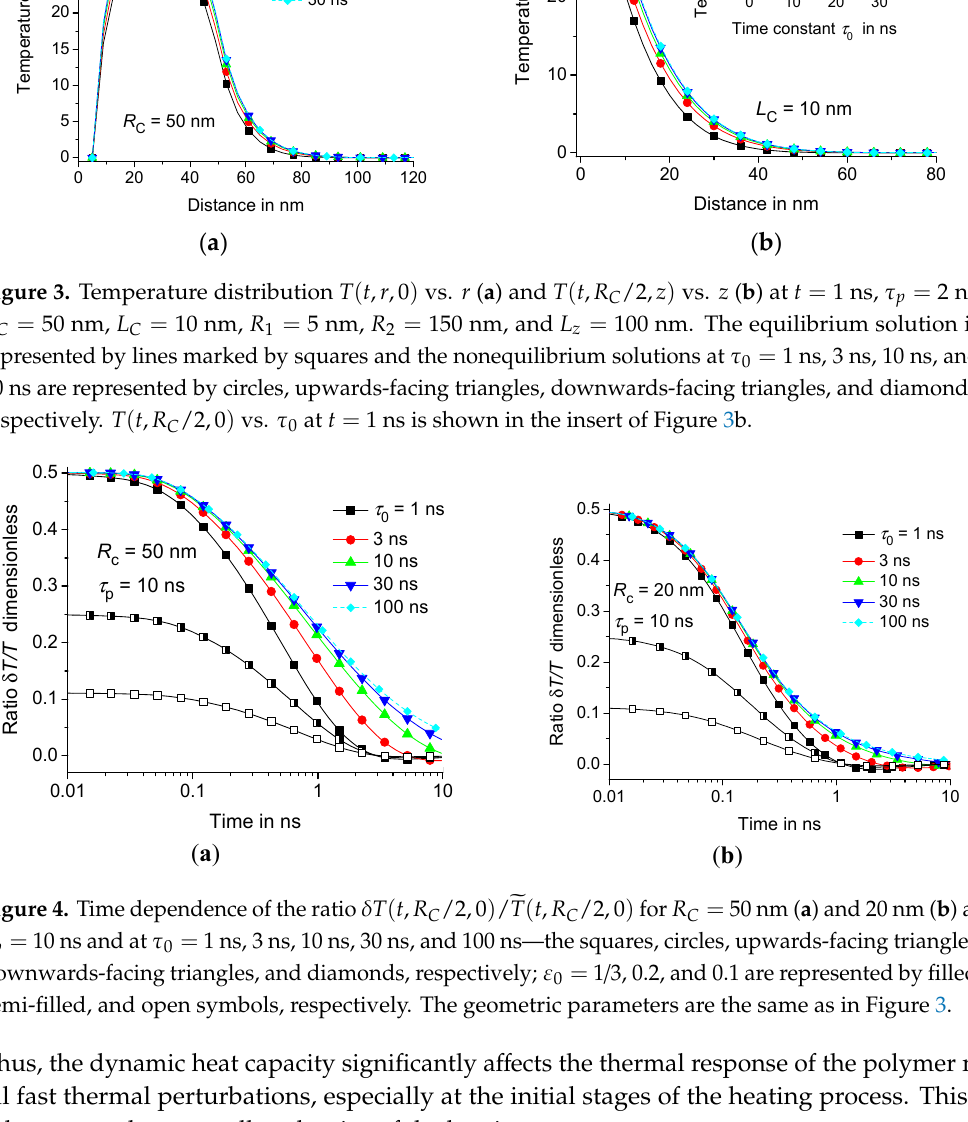
Molecules 2019 , 24 , x FOR PEER REVIEW